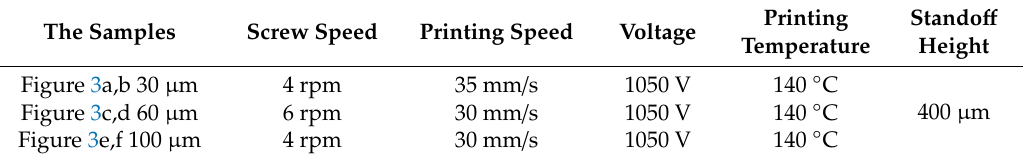
Table 2. The processing parameters for printing di ff erent line width.